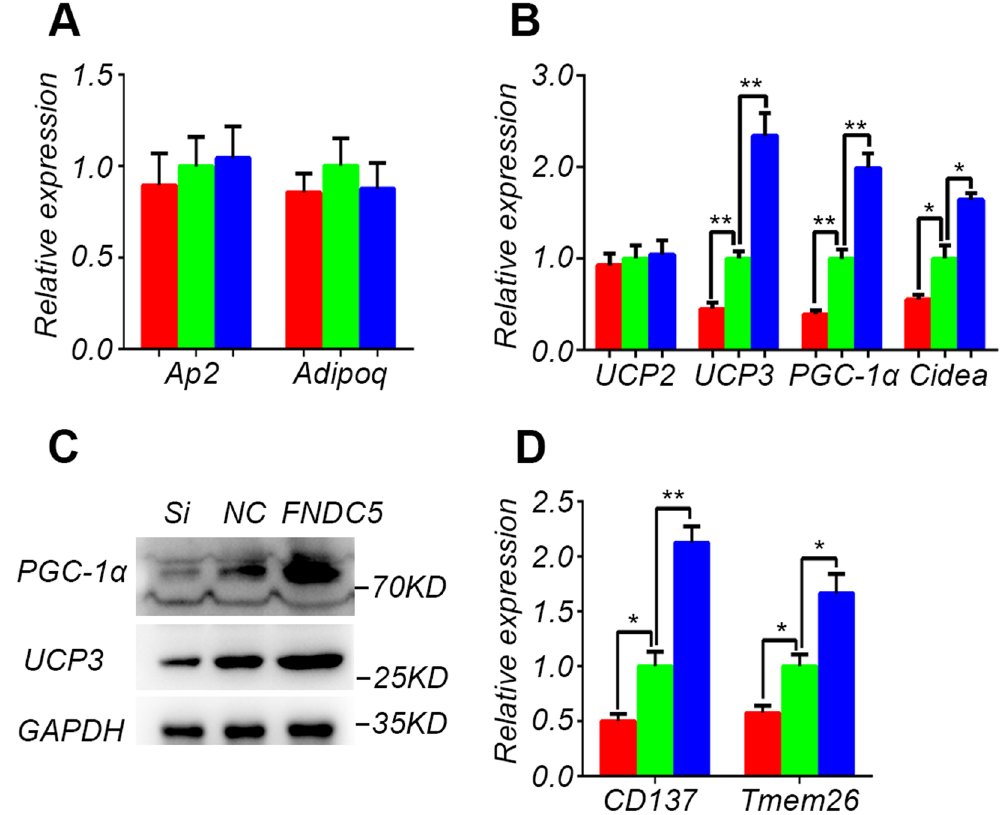
Figure 6. Enhancement of the browning of primary adipocytes by FNDC5 in Meishan pigs. Panels (A,B and D) represent the expression levels of marker genes for white fat, brown fat, and beige fat, respectively. Red column: RNAi transfected group; green column: control plasmid transfected group; blue column: control plasmid transfected group supplemented with recombinant FNDC5 protein. Data are reported as mean ± SEM (n = 3). * P < 0.05, ** P < 0.01. ( C ) Western blot of browning marker gene products. Si: RNAi transfected group;